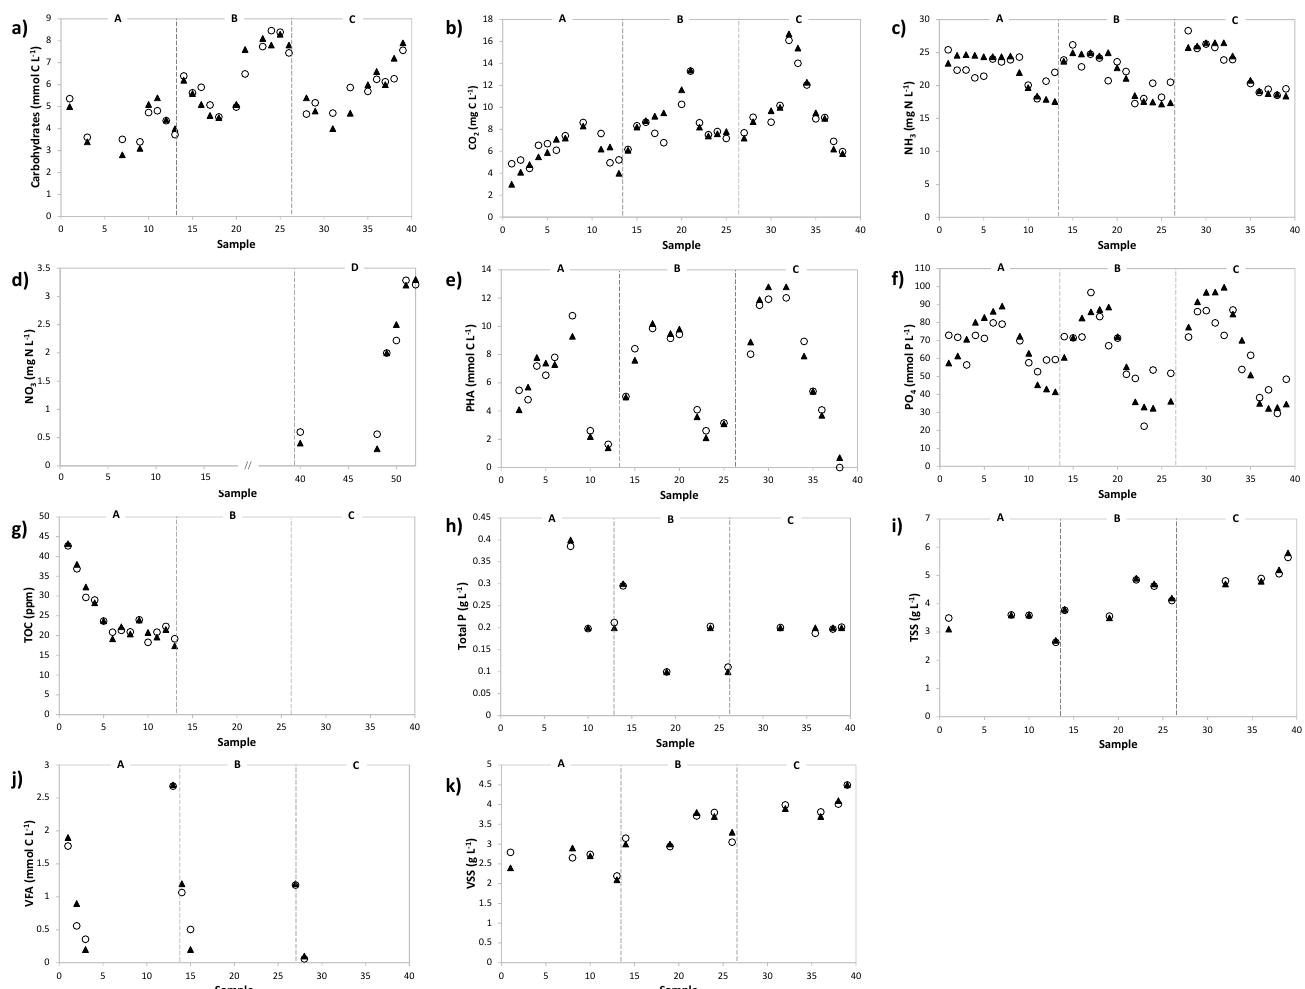
Figure 3. Representation of the prediction capabilities of the Raman-PLS models developed for ( a ) total carbohydrates; ( b ) carbon dioxide (CO 2 ); ( c ) ammonia (NH 3 ); ( d ) nitrate (NO 3 ); ( e ) polyhydroxyalkanoates (PHAs); ( f ) phosphate (PO 4 ); ( g ) total organic content (TOC); ( h ) total phosphorus (total P); ( i ) total suspended solids (TSSs); ( j ) volatile fatty acids (VFA); and ( k ) volatile suspended solids (VSSs). For each parameter and calibration sample, the analytical values measured by reference methods ( ▲ ) are represented along with the corresponding parameter values predicted by the respective cross- validation model ( ○ ). The pre-processing strategy, spectral regions, and number of latent variables used in the develop- ment of the PLS models are indicated in Table 1, for each studied parameter, along with the statistical cross-validation results. Vertical dashed lines separate the sample sets from each studied cycle, corresponding to the SBR operational days 73 (cycle A; samples 1 – 13); 79 (cycle B; samples 14 – 26); 85 (cycle C; samples 27 – 39); and 101 (cycle D; samples 40 – 52).